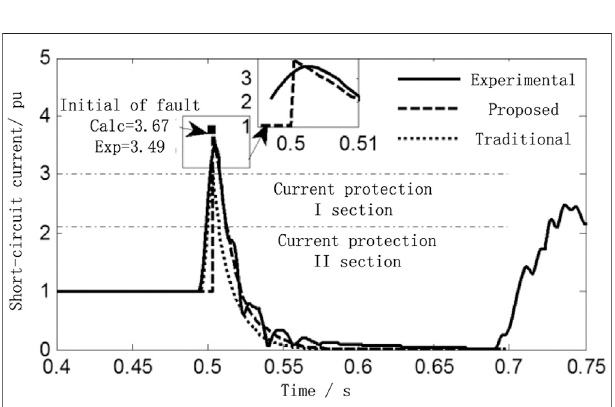
FIGURE 8 | Comparison fi gure between calculation result and experimental result of DFIG three-phase short circuit at bus C.